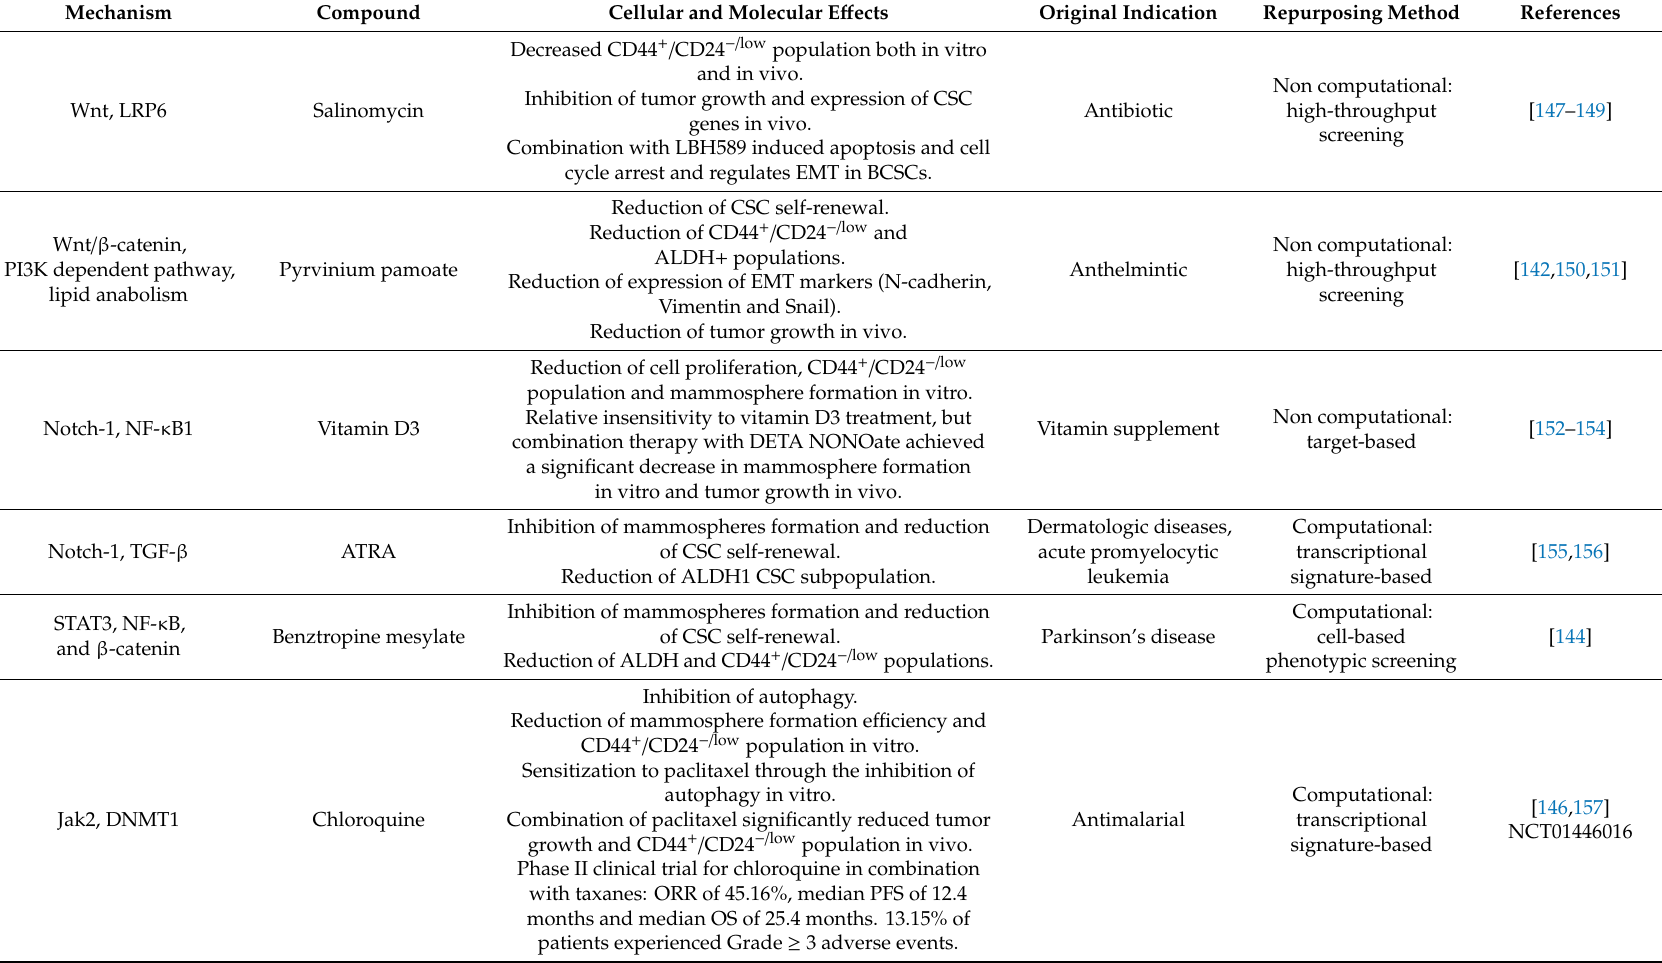
Table 5. Summary of drug candidates to target cancer stem cells (CSCs) under investigation by drug